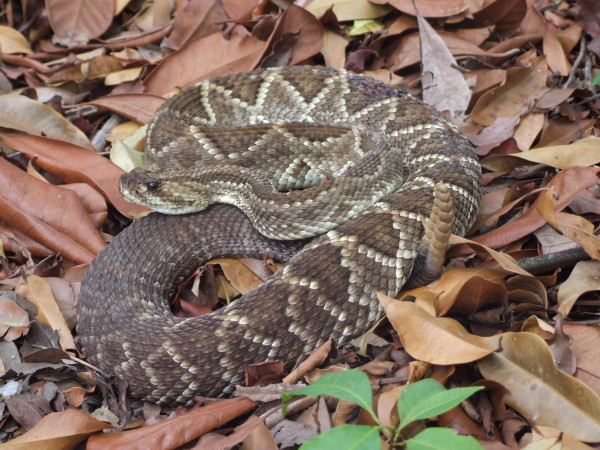
Crotalus durissusLinnaeus, 1758 (Photo – Gentil Pereira Filho).